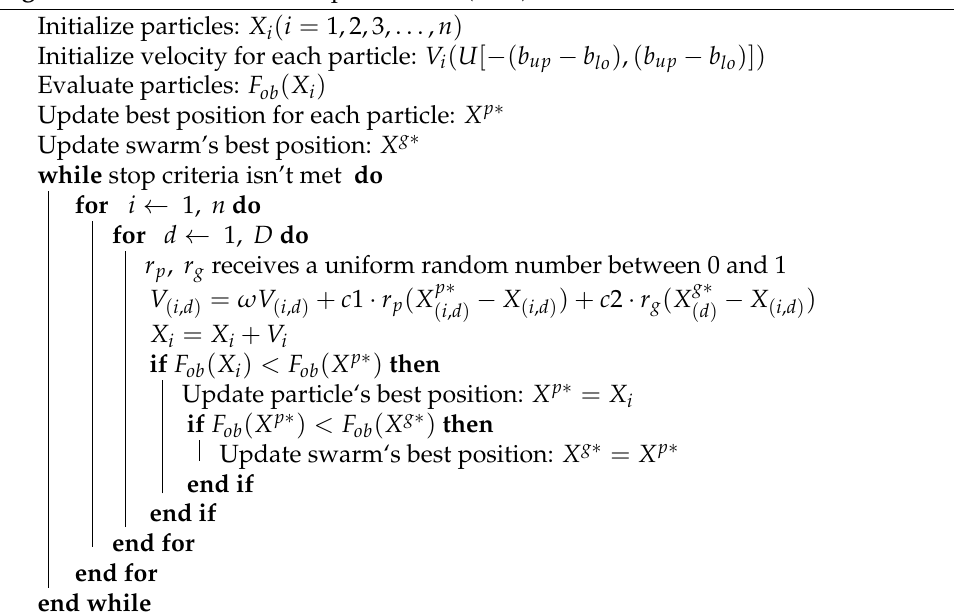
Algorithm 5 Particle Swarm Optimization (PSO)